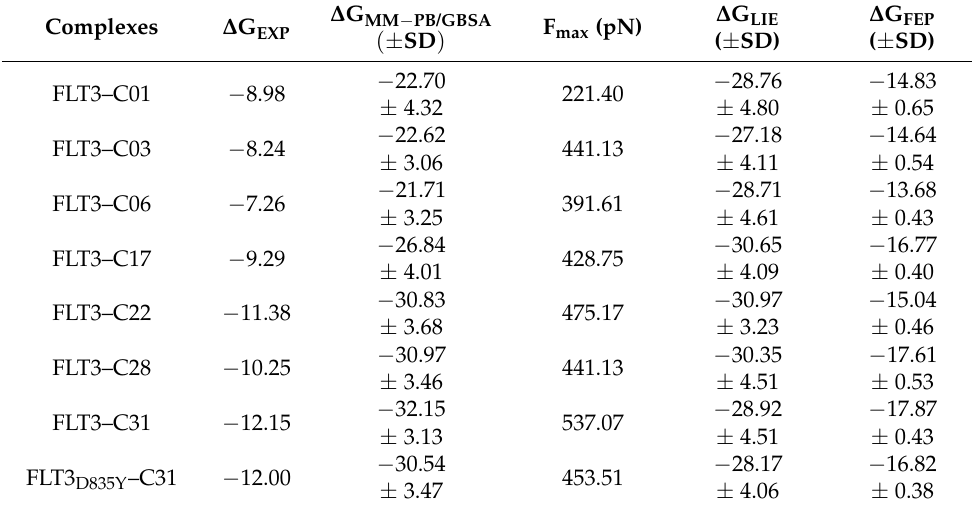
Table 1. Experimental and calculated binding energies from MM-PB/GBSA, FPL, LIE, and FEP calculations. Except for the rupture force (F max ), all binding energy terms are expressed in kcal/mol. ∆ G ∆ G MM − PB/GBSA Complexes ∆ G EXP F max (pN) ( ± SD )